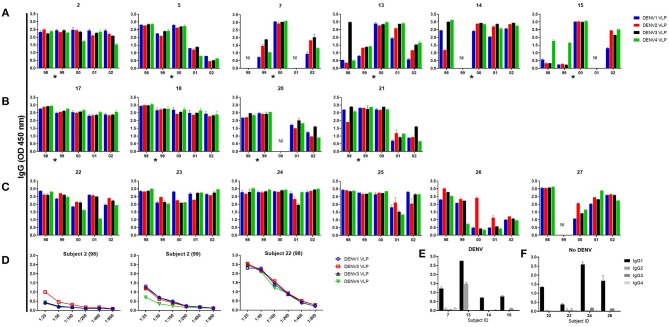
Memory B cell responses to DENV. Peripheral blood mononuclear cells from 6 subjects with symptomatic secondary DENV infection (subjects 2 and 5 were not hospitalized, subjects 7, 13, 14, and 15 were hospitalized) (A), 4 subjects with subclinical infection (B), and 6 subjects with no DENV infection (C) were cultured with R848 plus IL-2 for 7 days and supernatants were tested for DENV-specific IgG Abs. Representative data of supernatant dilution from a subject with symptomatic and no DENV infection (D). DENV-specific IgG isotypes in supernatants from the year 2000 in 4 subjects with DENV and 4 subjects with no DENV, respectively (E,F). Bars represent mean with standard error of the mean of the OD values. The asterisk indicates the approximate time when DENV infection occurred. NI, not included.